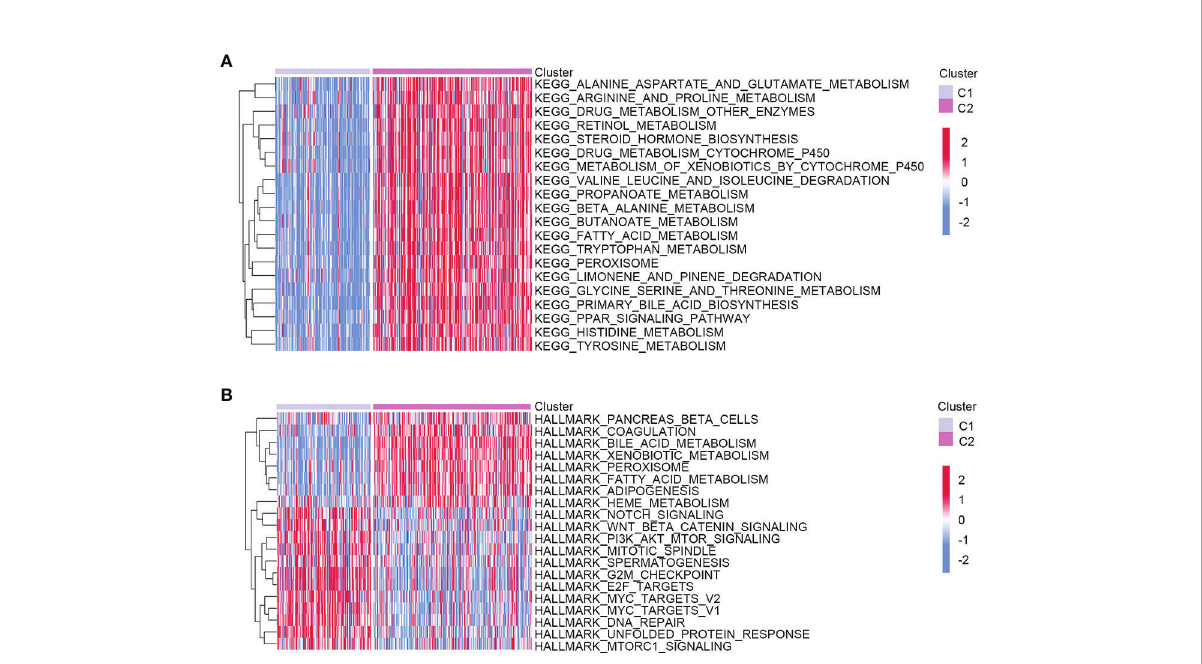
Table S3). Then, by the LASSO algorithm and multivariate Cox